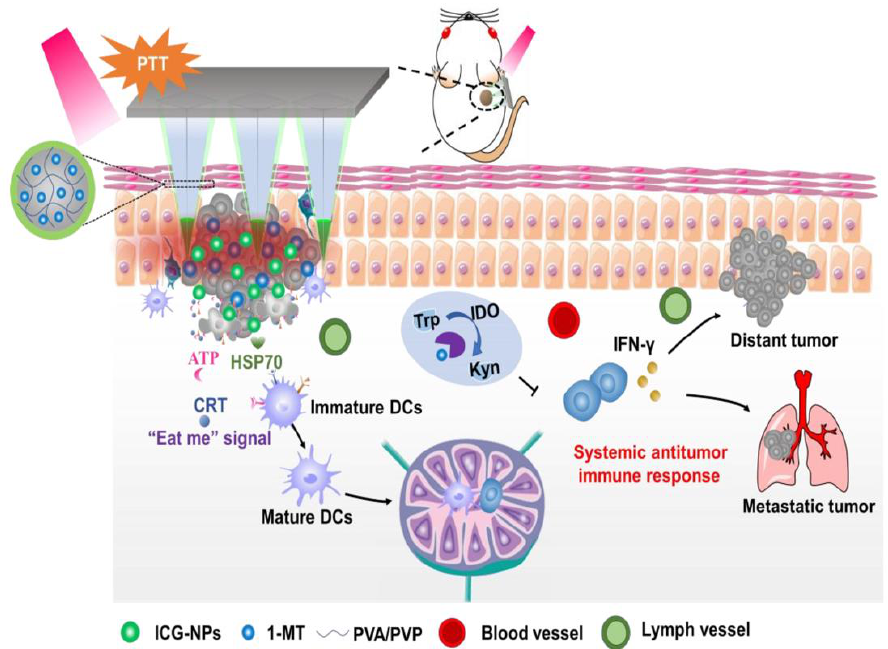
Figure 5. Graphical presentation of the mechanism for the antitumor effect of microneedles in combination with indocya- nine green-loaded chitosan NPs